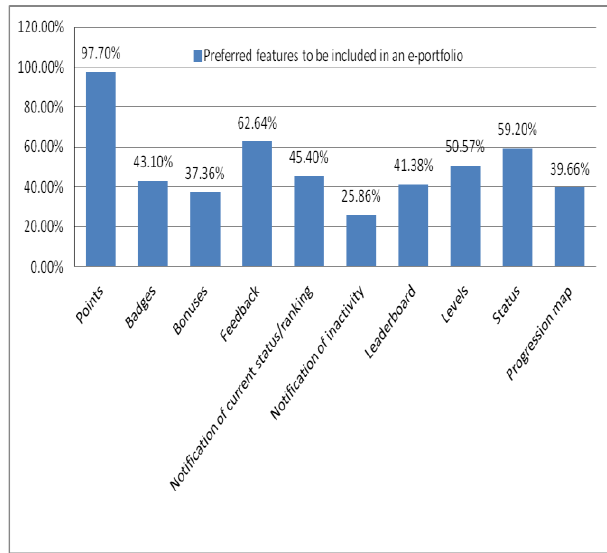
Figure 9. Preferred features to be included in an